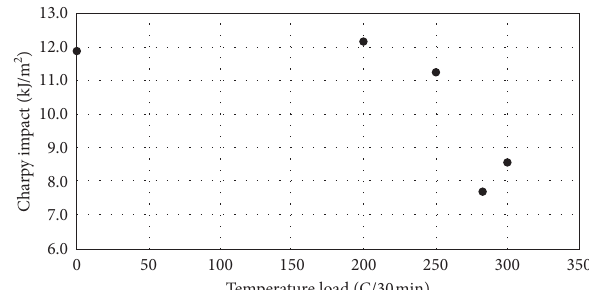
Figure 4: BMC material loss in relation to temperature load.